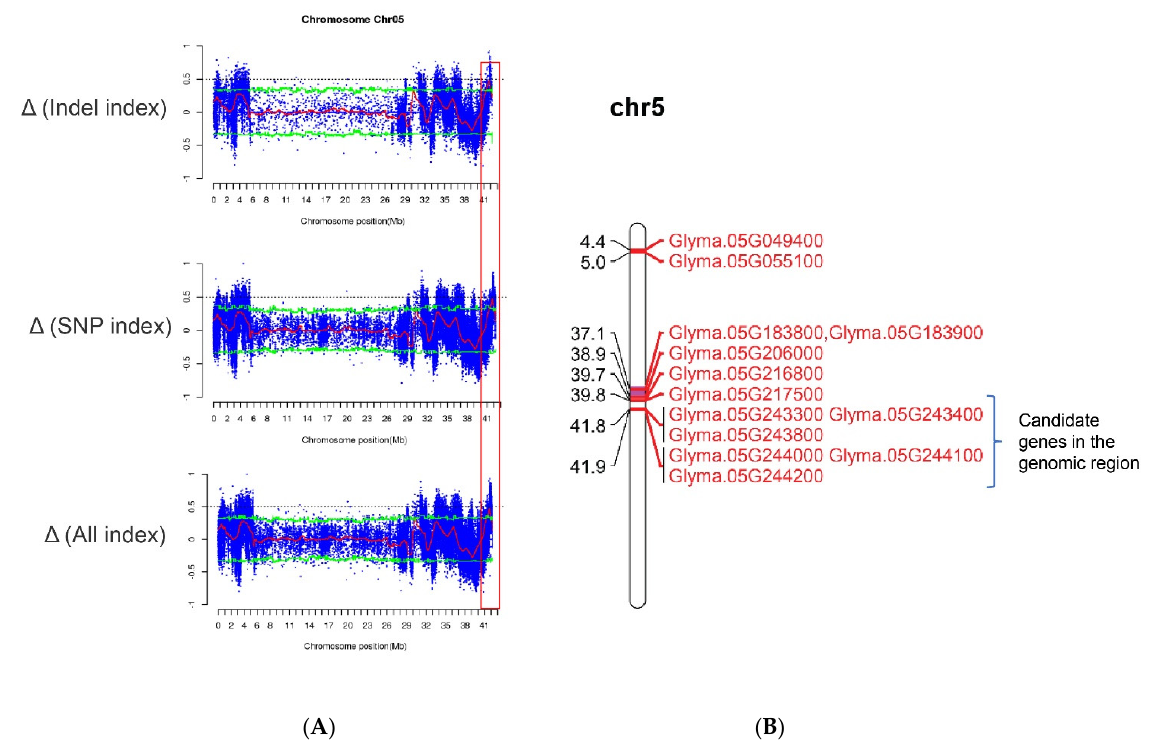
Figure 2. Variant association analyses for identification of the candidate regions related to tocopherol content in soybean based on BSA-seq of a panel of soybean accessions. ( A ) Visualization of the ∆ (InDel index) and ∆ (SNP − index) plots with statistical confidence intervals ( p < 0.05). The dotted ash line represents SNP/InDel indices. The blue dots and red line represent ∆ (SNP − index) and the sliding window average of ∆ (SNP/InDel − index) calculated based on a 2 Mb interval with a 10kb sliding window. The green dotted line shows the association threshold value (0.90). ( B ) Candidate genes in the genomic locus (41.8 and 41.9) on chromosome 5.